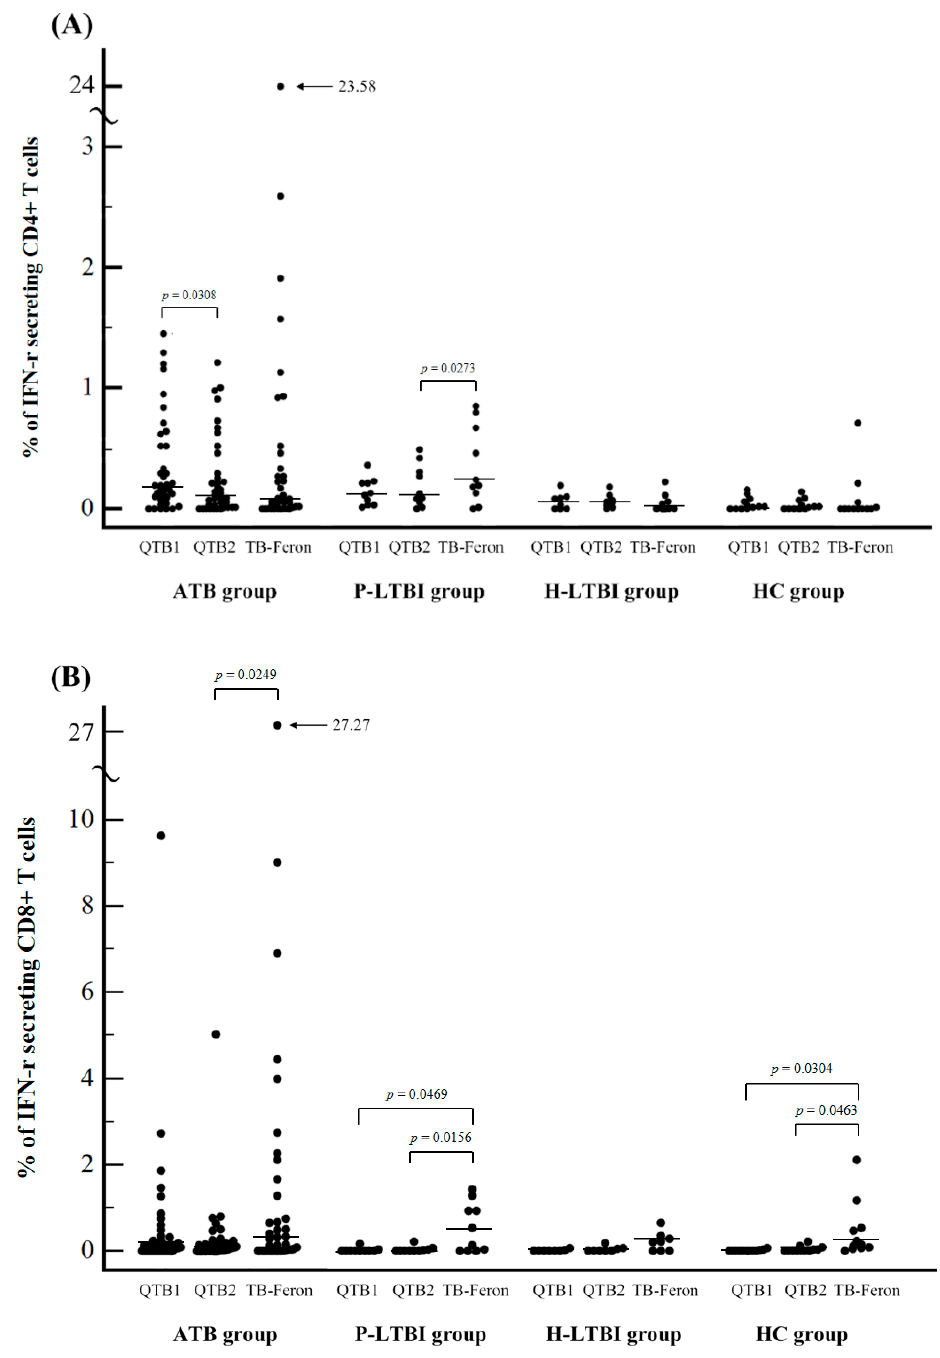
Figure 3. Distribution of TB antigen-specific IFN- γ secreting T cells in response to TB antigens in the QFT-Plus and TB-Feron assays measured using flow cytometry intracellular cytokine analysis. ( A ) CD4+ T cells ( B ) CD8+ T cells; Abbreviation: TB, tuberculosis; IFN- γ , interferon-gamma; QTB1, QFT-Plus TB1 tube, QFT2, QFT-Plus TB2 tube.